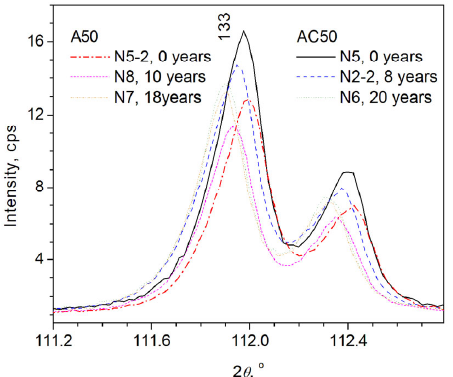
Figure 12. Part of the XRD patterns in the vicinity of the hkl = 133 reflection for several A50 and AC50 samples.